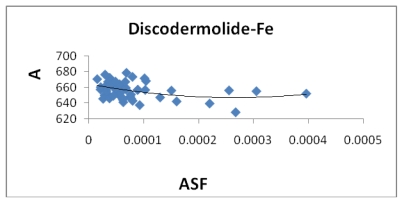
The area (Å2) plotted against the aqueous stability factor (Jm/D) for discodermolide bound to only iron. The best fit equation is a polynomial y = 3*108x2 − 134702x + 664.51 and a correlation coefficient of R2 = 0.1468.